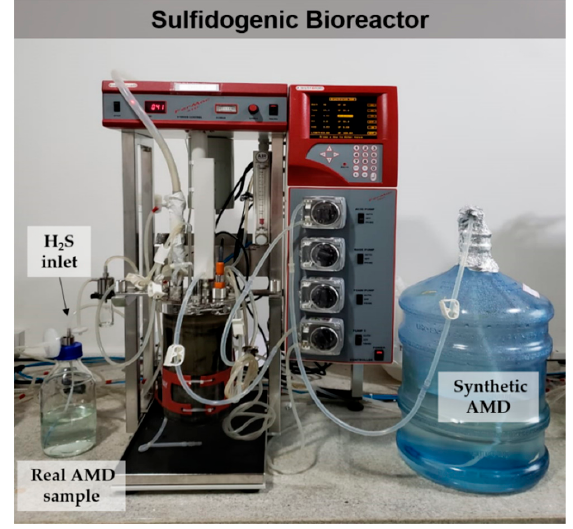
Figure 1. Real AMD sample (Schott glass bottle) exposed to biogenic H 2 S for covellite (CuS) production.